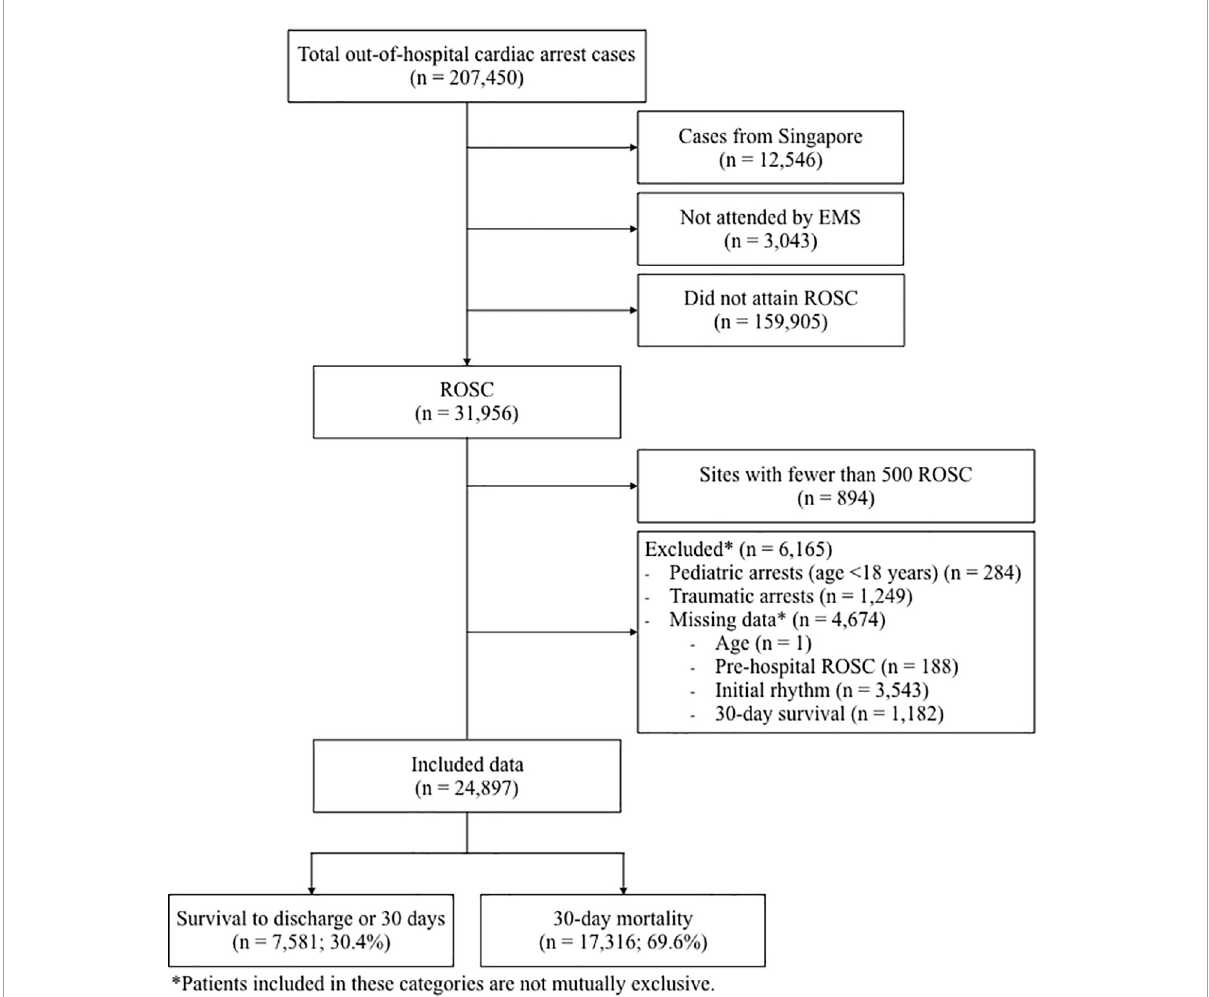
FIGURE1 Population flow diagram showing cohort selection. EMS, emergency medical services; ROSC, return of spontaneous